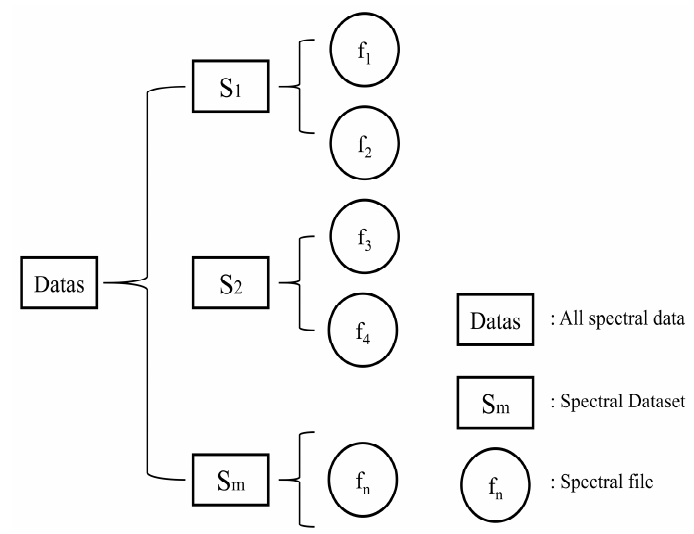
Figure 8. File structure of the big data management system.